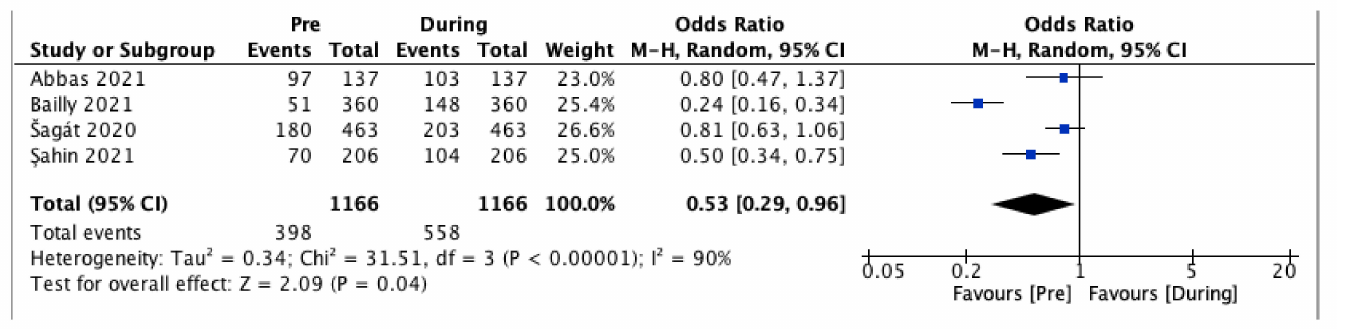
Figure 2. Low back pain prevalence. Before versus during the pandemic [34,36–38].